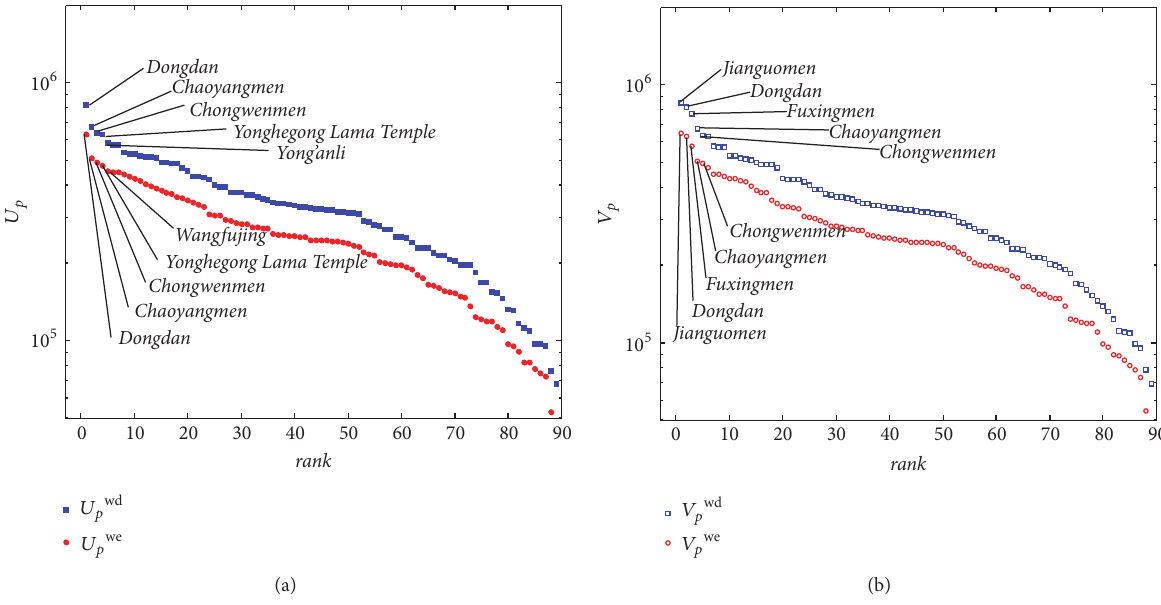
Figure 5: Incoming and outgoing passenger flows distributions. The weight of incoming flow on weekday and weekend 𝑈 𝑝 wd and 𝑈 𝑝 we can be fitted by exponential distributions with exponents 𝜃 = 0.0167 and 𝜃 = 0.0184 , respectively. The goodness-of-fit ( 𝑅 2 ) are 0.97 and 0.96. The weight of outgoing flows 𝑉 𝑝 wd and 𝑉 𝑝 we can be fitted by exponential distributions with exponents 𝜃 = 0.0173 and 𝜃 = 0.0183 , respectively. The goodness-of-fit ( 𝑅 2 ) are both